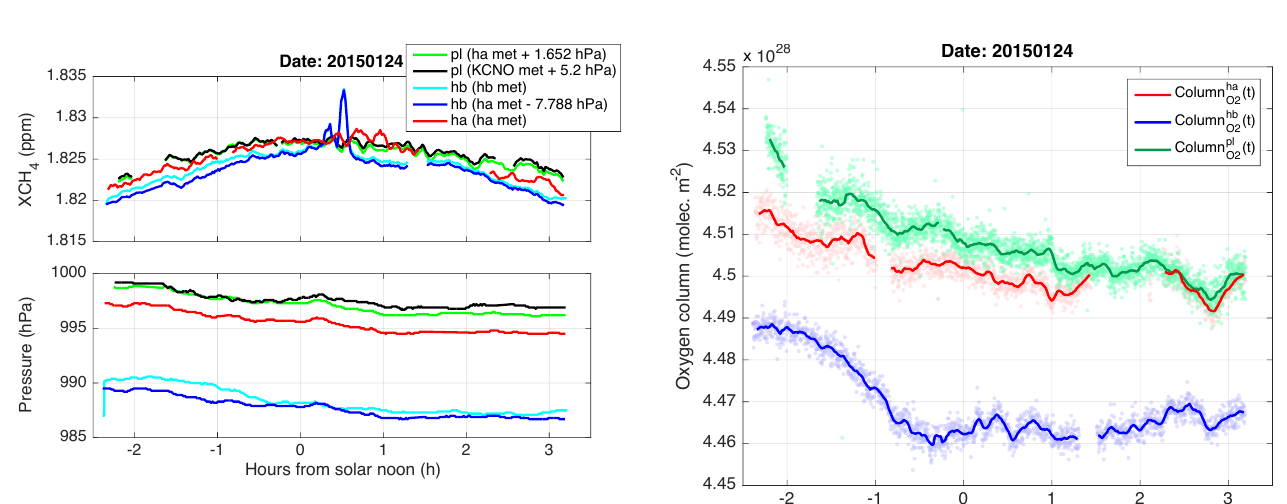
Figure C1. Surface pressure inputs (lower panel) and the corre- retrieval results using 5min moving average (upper sponding X CH 4 panel). For Fig. 4a and the simple column model calculations, ha, hb, and pl retrievals with the surface pressure inputs based on ha on- site pressure measurements are used (red, blue, and green curves).